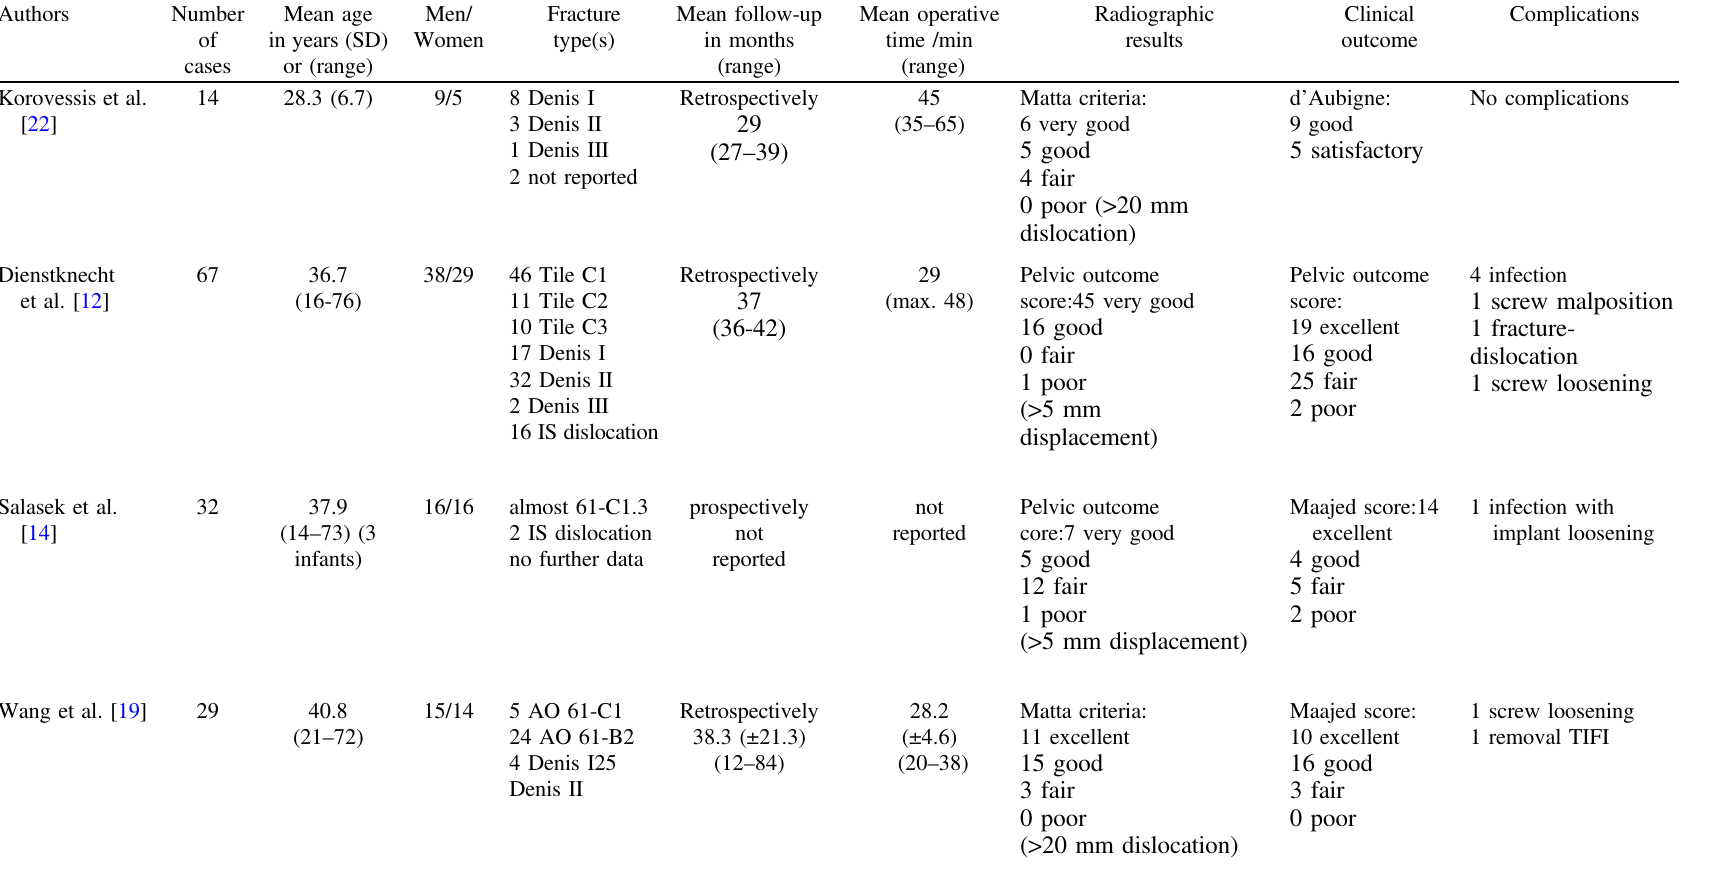
Table 1. Clinical studies with TIFI and reported data for this